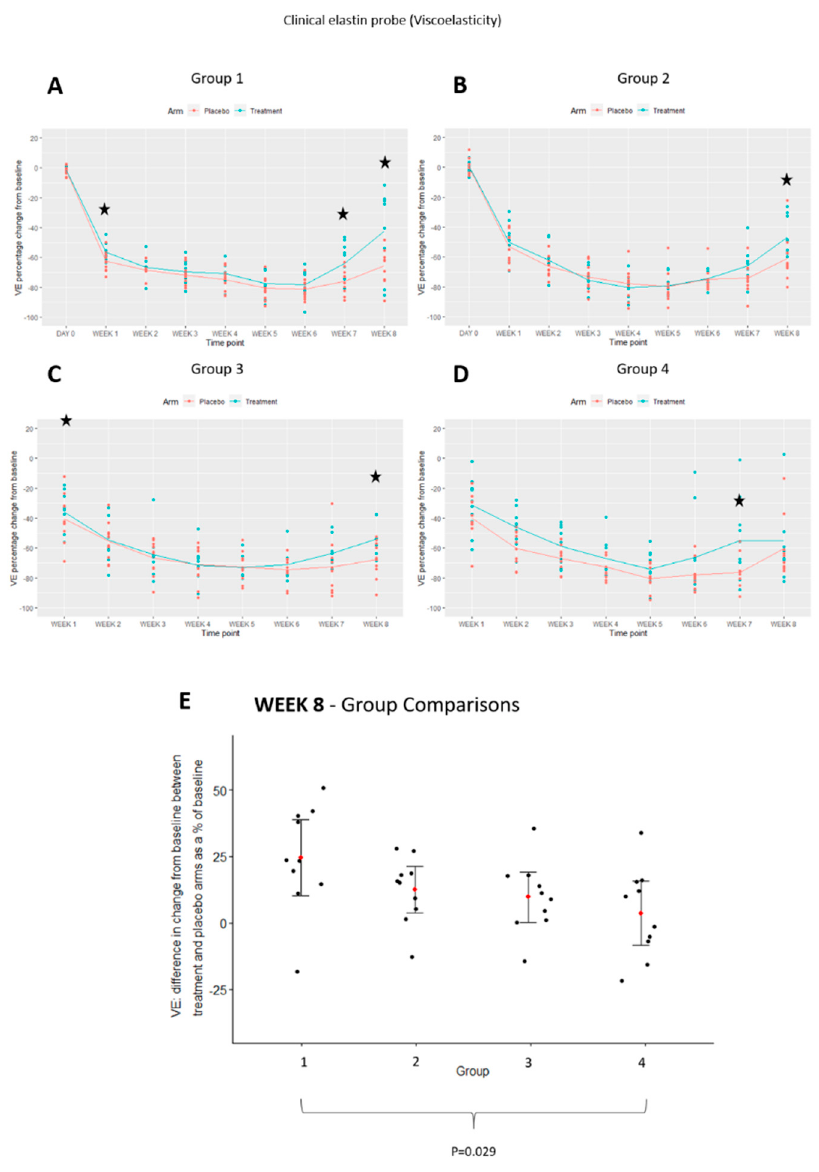
Figure 24. Clinical elastin probe analysis of topical epigallocatechin-3-gallate (EGCG) versus placebo. ( A ) Clinical elastin probe viscoelasticity measurements are presented for Group 1. ( B ) Group 2 viscoelasticity measurements. ( C ) Group 3 viscoelasticity measurements. ( D ) Group 4 viscoelasticity measurements. ( E ) Between group comparisons for viscoelasticity at week 8. Significance: ★ p ≤ 0.01. (cid:70) p ≤